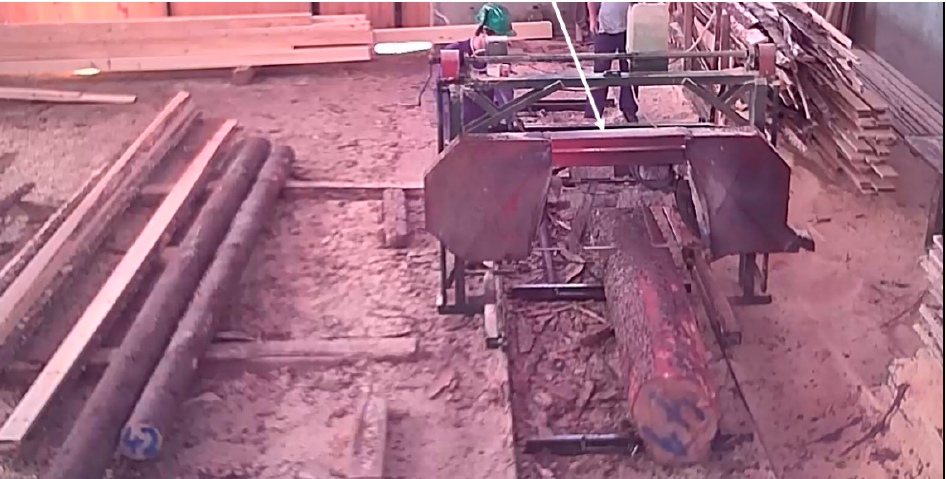
Figure 1. A snapshot extracted from the collected video files showing the general configuration of the machine taken into study and the labelled logs.